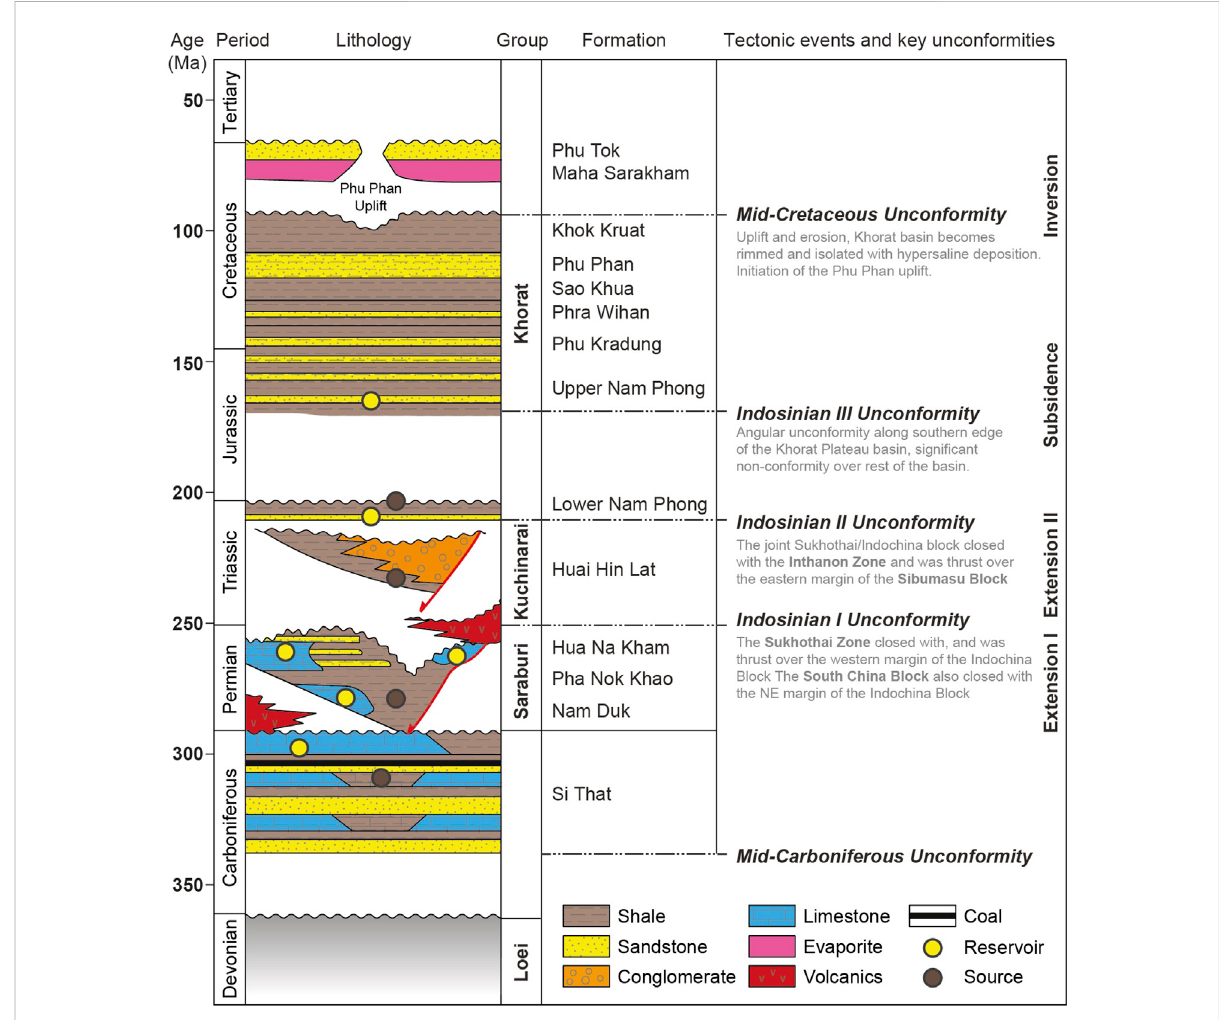
FIGURE 4 Stratigraphic framework of theKhoratPlateau(modi fi ed from Sattayaraket al., 1989; Koysamran and Comrie-Smith, 2011;Racey, 2011;Schenk et al., 2017). The potential reservoir and source rocks are indicated as yellow and brown dots,